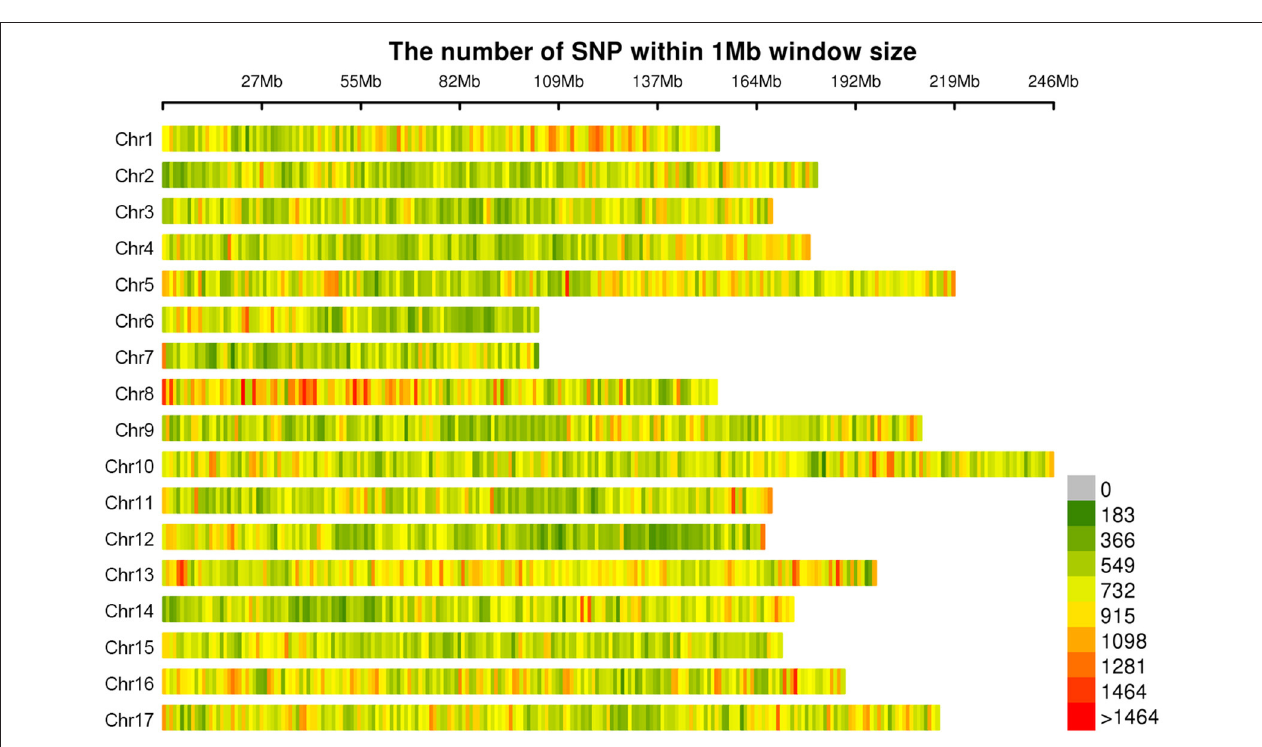
up-regulated DEGs ( Figure 9 ). From day-7 to day-14, the up-regulated DEGs were increasing from 3,848 to 7,174, whereas the down-regulated DEGs were increasing from 5,201 to 8,521,